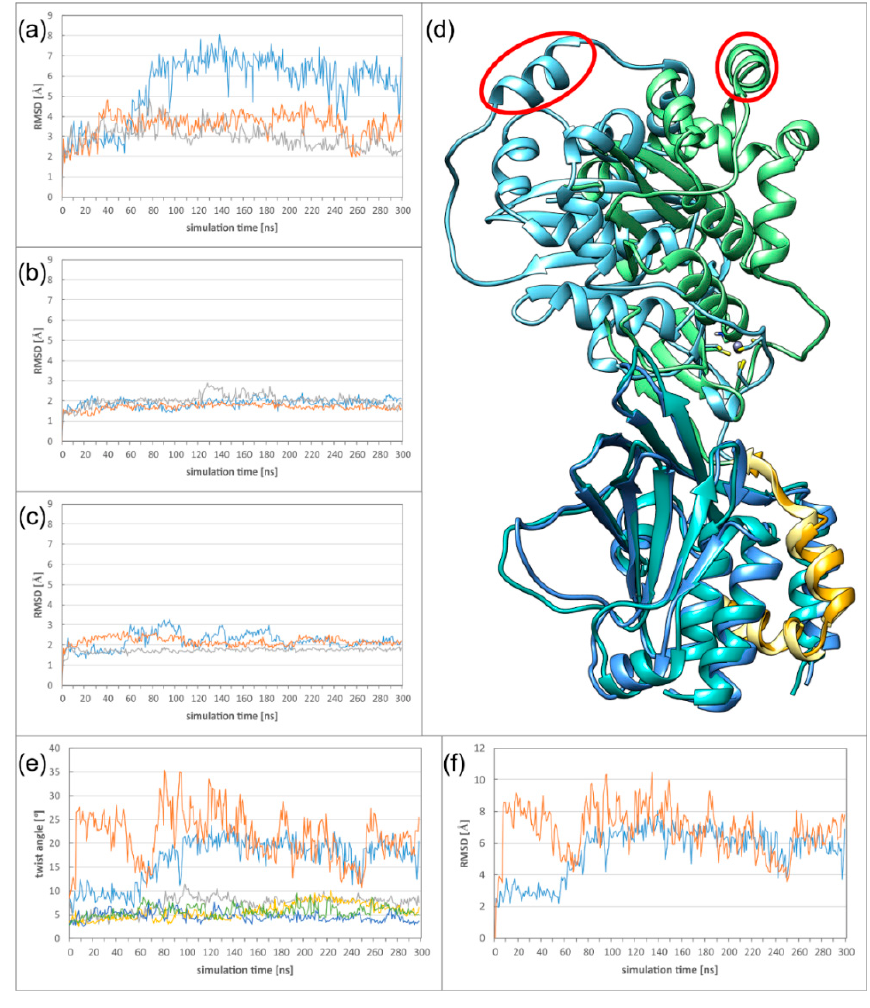
Figure 4 . Dynamics of the NEC heterodimers ( a ) RMSD (root ‐ mean ‐ square deviation) plot of the complete NECs of HCMV (blue), HSV ‐ 1 (orange), and PRV (grey). ( b ) RMSD plot of the pUL53 (pUL31) subdomain of HCMV (blue), HSV ‐ 1 (orange), and PRV (grey). ( c ) RMSD plot of the pUL50 (pUL34) subdomain of HCMV (blue), HSV ‐ 1 (orange) and PRV (grey). ( d ) Overlay of the HCMV NEC starting structure and the twisted structure after 120 ns simulation time. The proteins are coloured according to the scheme established in Figure 1. One of the pUL53 helices is marked by a red ellipse to illustrate the extent of the twist. ( e ) Plot illustrating the twist in the two simulation runs of HCMV (blue and orange), HSV-1 (grey and yellow), and PRV (green and dark blue). ( f ) RMSD plot of the complete HCMV NEC in two runs.